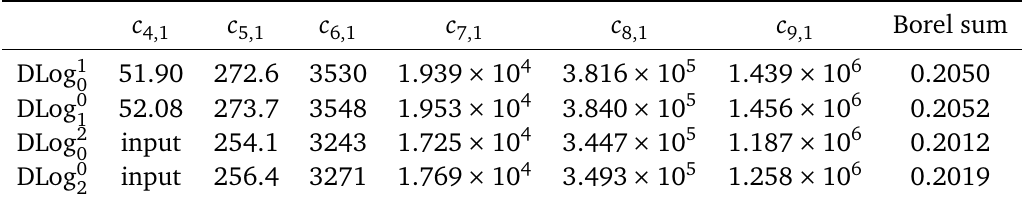
Table 2: QCD Adler function coefficients from D-Log Padé approximants to B [ δ ( 0 ) ]( u )